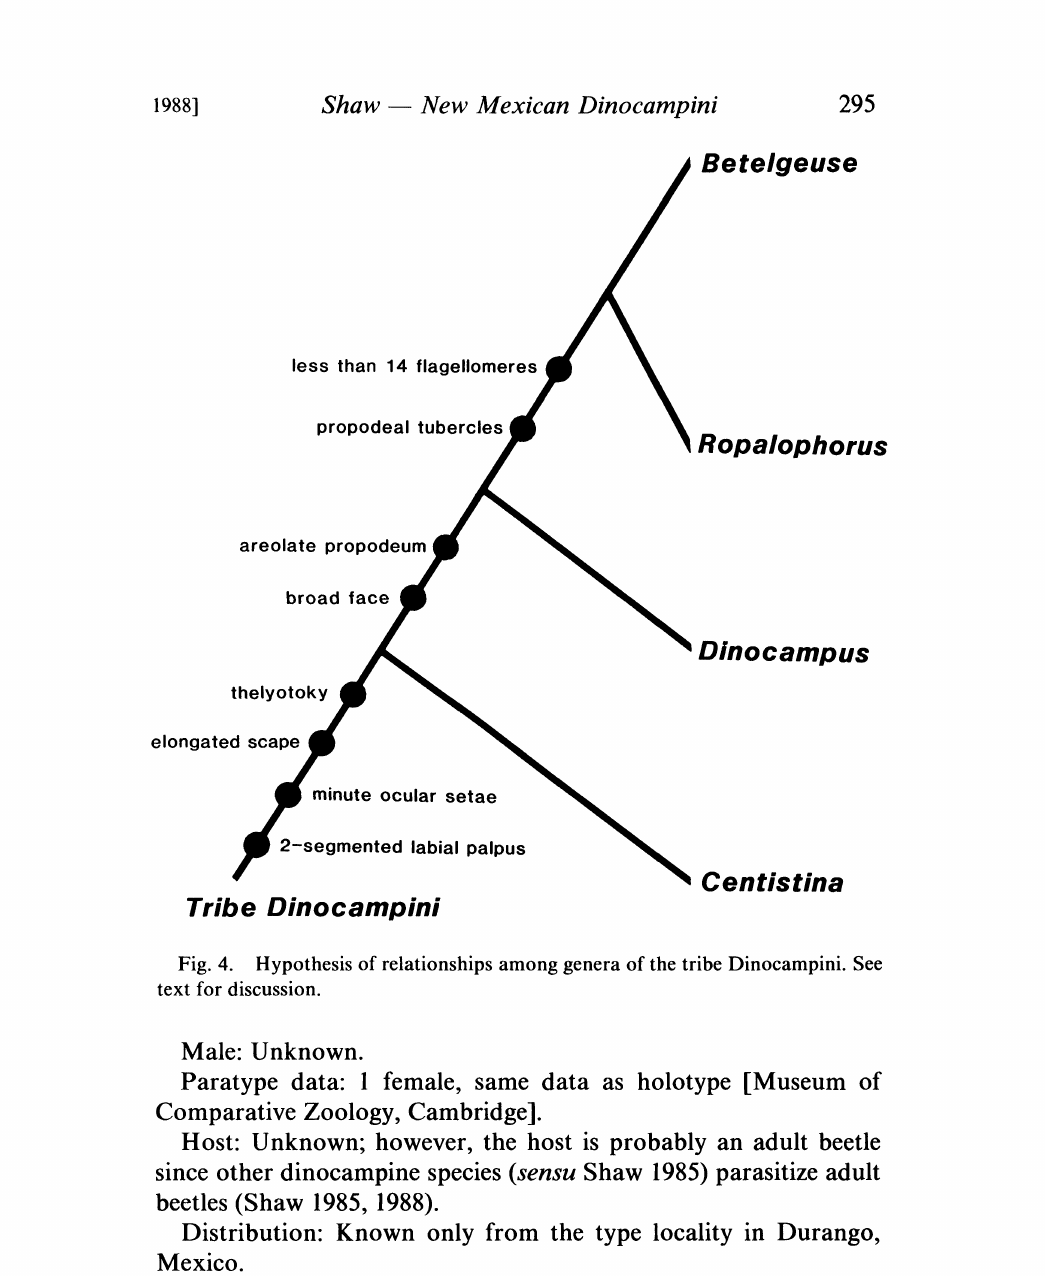
Fig. 4. Hypothesis of relationships among genera of the tribe Dinocampini. See text for